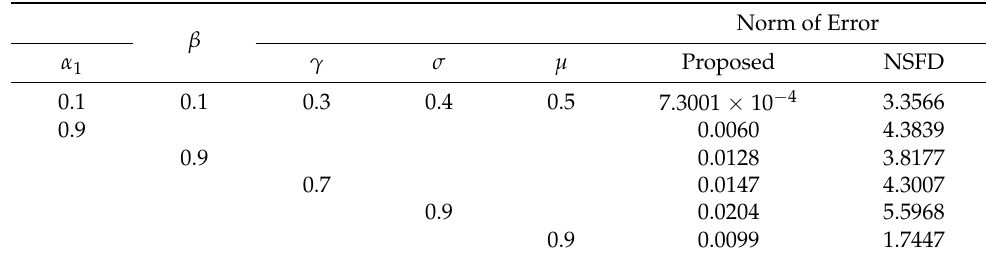
Table 1. Comparison of proposed and NSFD schemes over spatial coordinate x using d 1 = 2, d 2 =